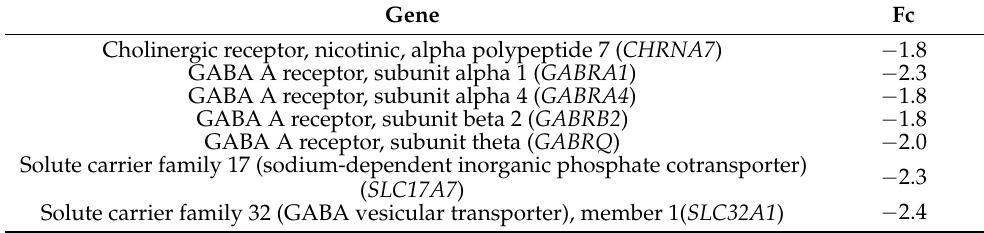
Table 8. Changes in gene expression in dogs fed with polyherbal vs. choline chloride in nicotine addiction